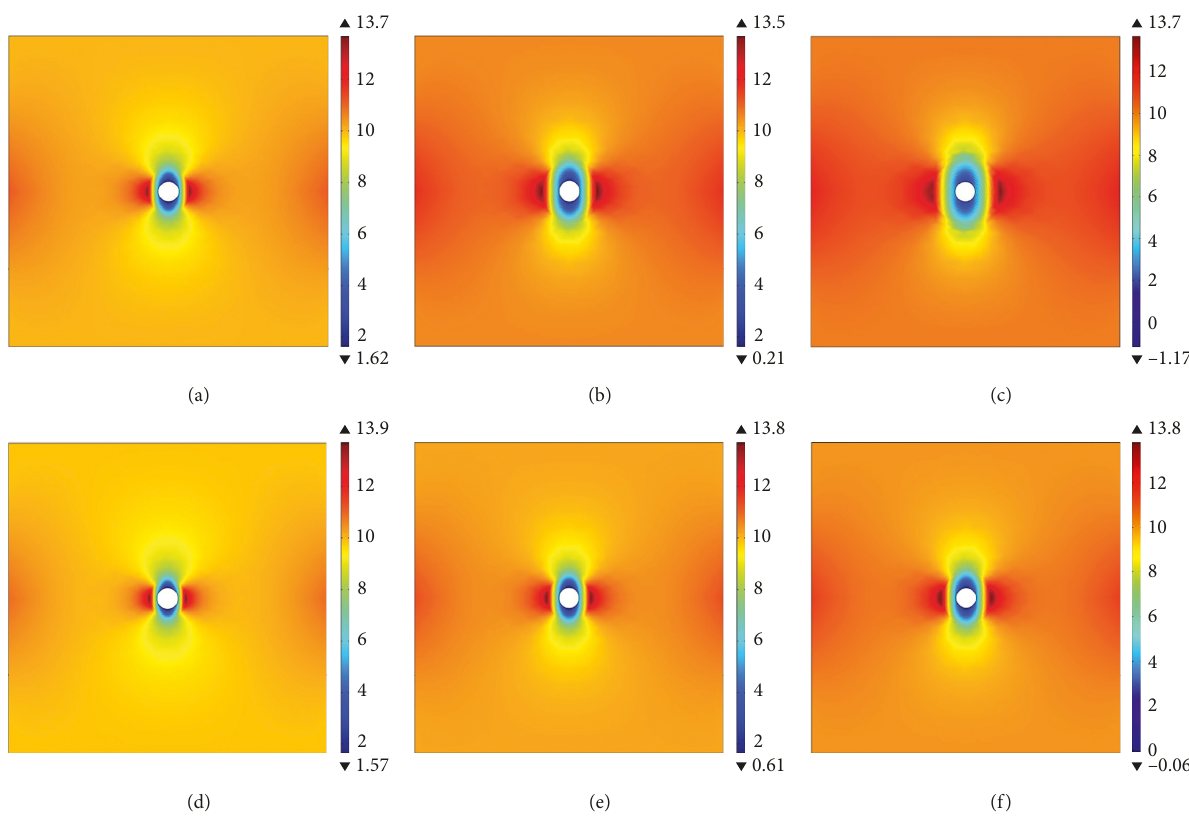
Figure 10: Distribution of vertical stress around borehole. (a) No active support, 1d. (b) No active support, 2d. (c) No active support, 5d. (d) Active support, S 1 -1d. (e) Active support, S 1 -2d. (f) Active support, S 1